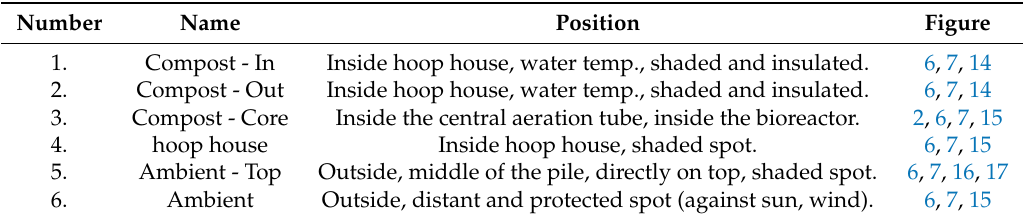
Table 1. Summary of thermometer labels, locations and appearance in